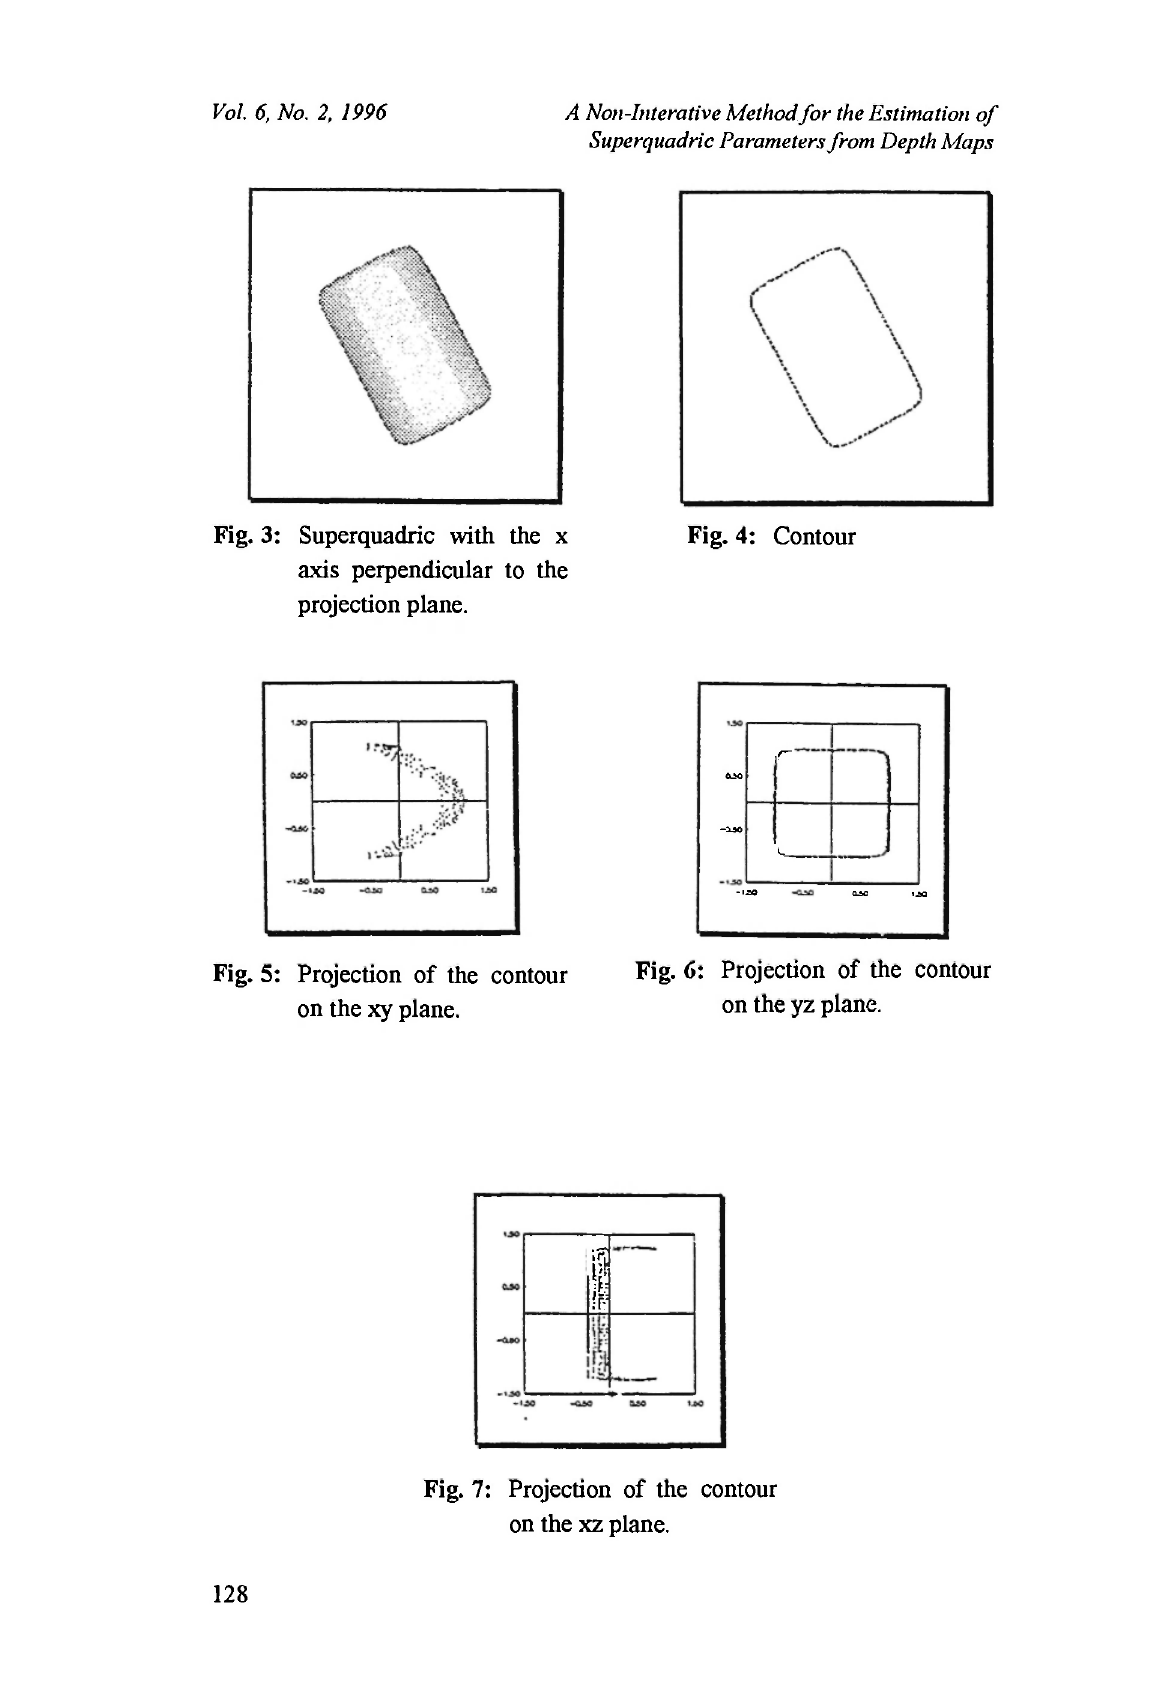
Fig. 7: Projection of the contour on the xz